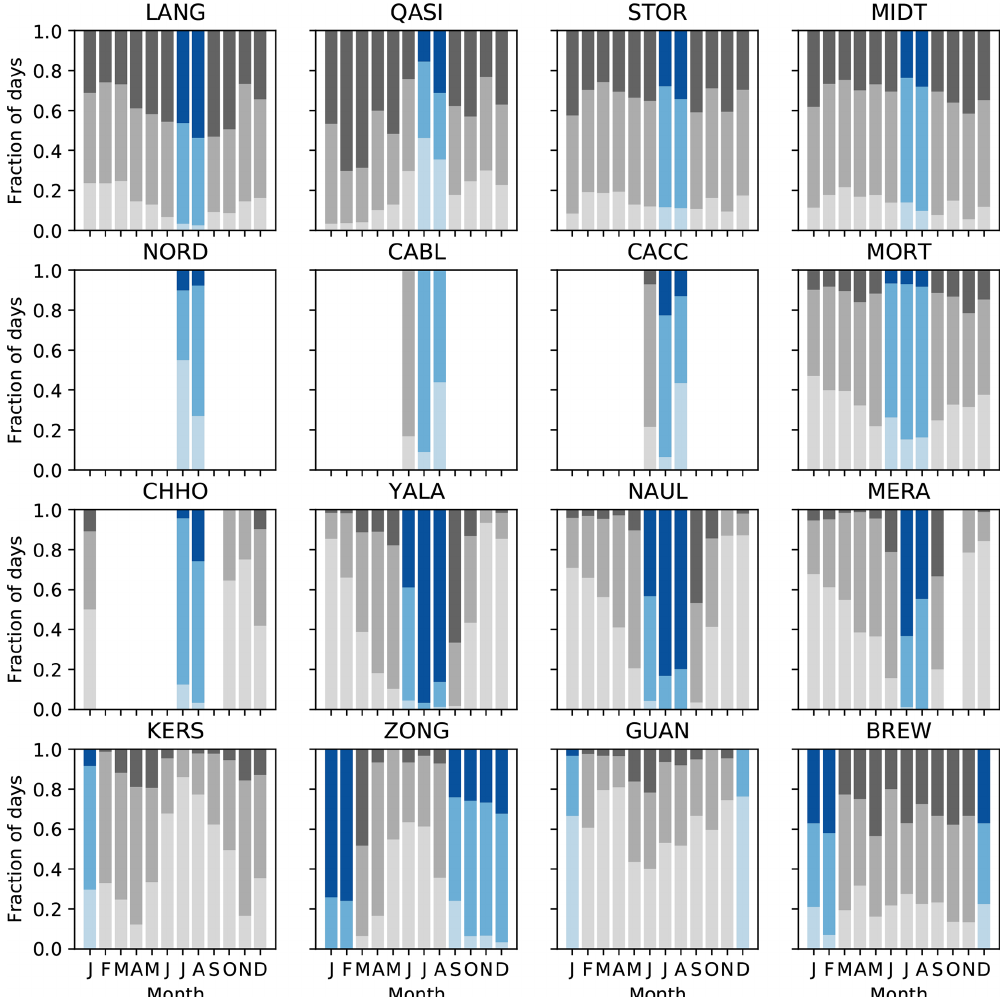
Figure A6. As for Fig. 5 but with months with > 80% of maximum monthly average Q M shaded blue. Bars show monthly fraction of clear-sky (light shading), partially cloudy (mid shading) and overcast conditions (dark shading) defined using daily average cloudiness ( N ε ).